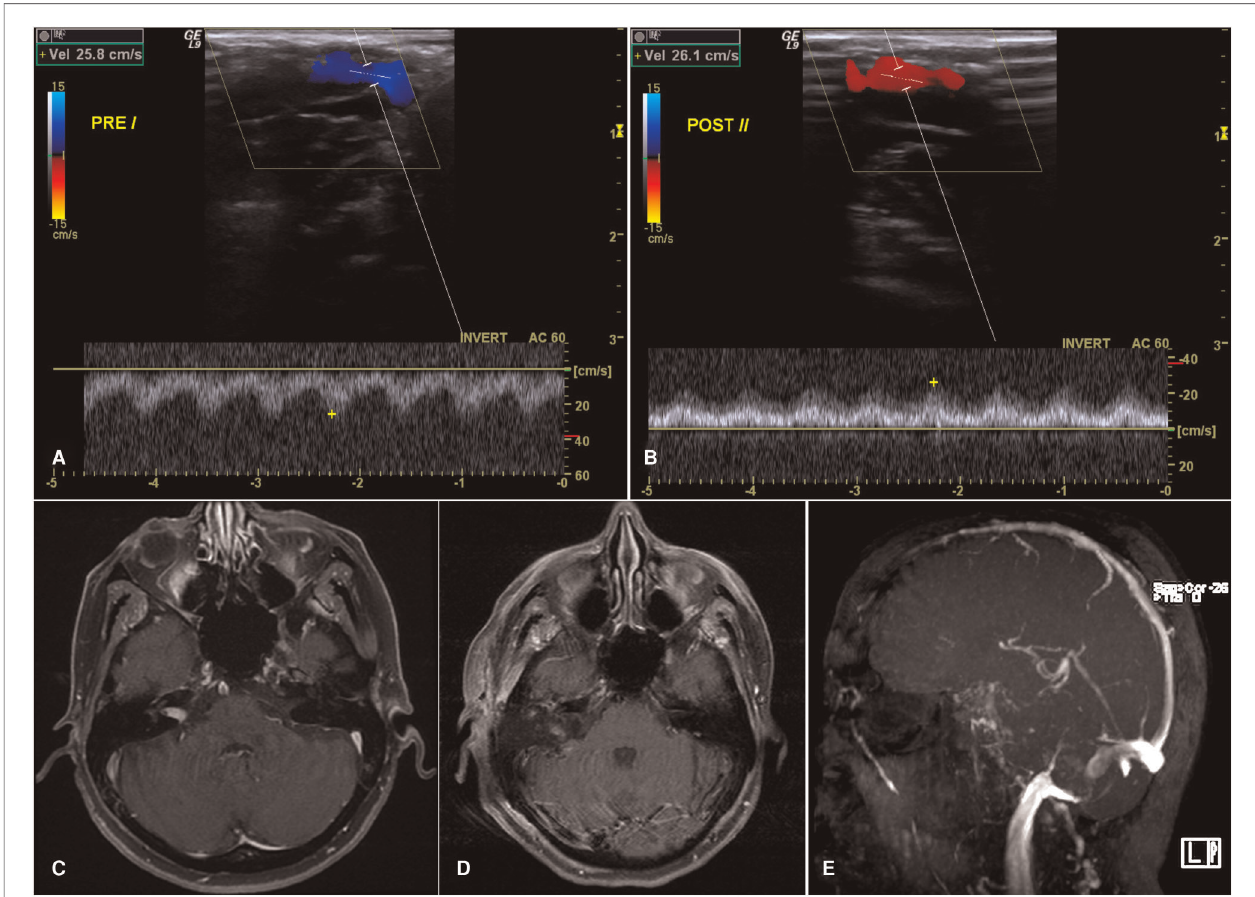
FIGURE 2 | 69 year-old female with a right intracanalicular vestibular schwannoma who underwent a translabyrinthine approach for resection due to worsening of clinical symptoms. ( A ) Doppler ultrasound of the sigmoid sinus prior to dural opening. ( B ) Doppler ultrasound of the sigmoid sinus prior to closure. ( C ) Pre-operative MRI brain with contrast demonstrating an intracanalicular vestibular schwannoma. ( D ) Post-operative MRI with contrast and fat saturation showing a gross total resection of the vestibular schwannoma. ( E ) Post-operative MRA-TOF of the brain with signi fi cant stenosis of the right sigmoid